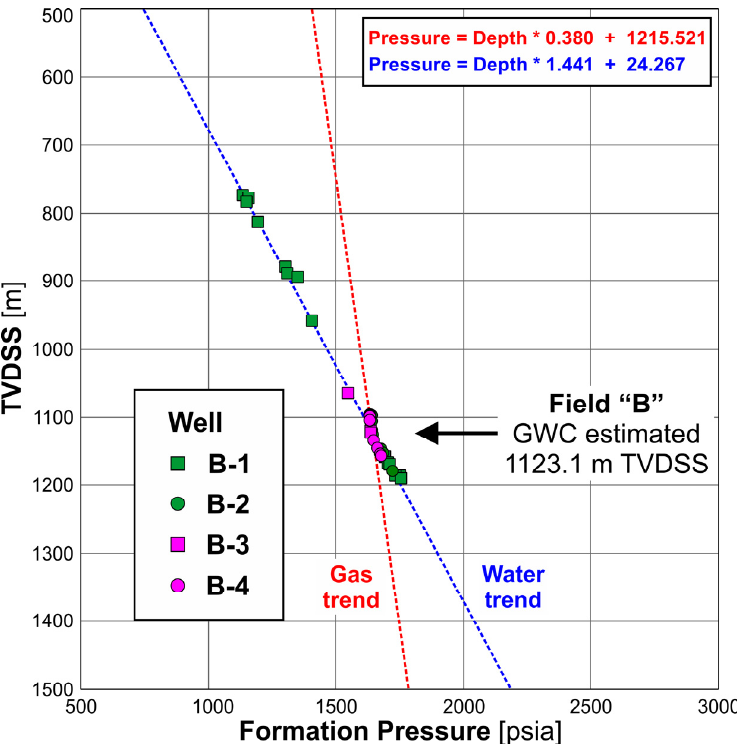
17 Figure 17. Estimation of gas–water contact (GWC) for field “B” by jointly using pressure measure- ments from available